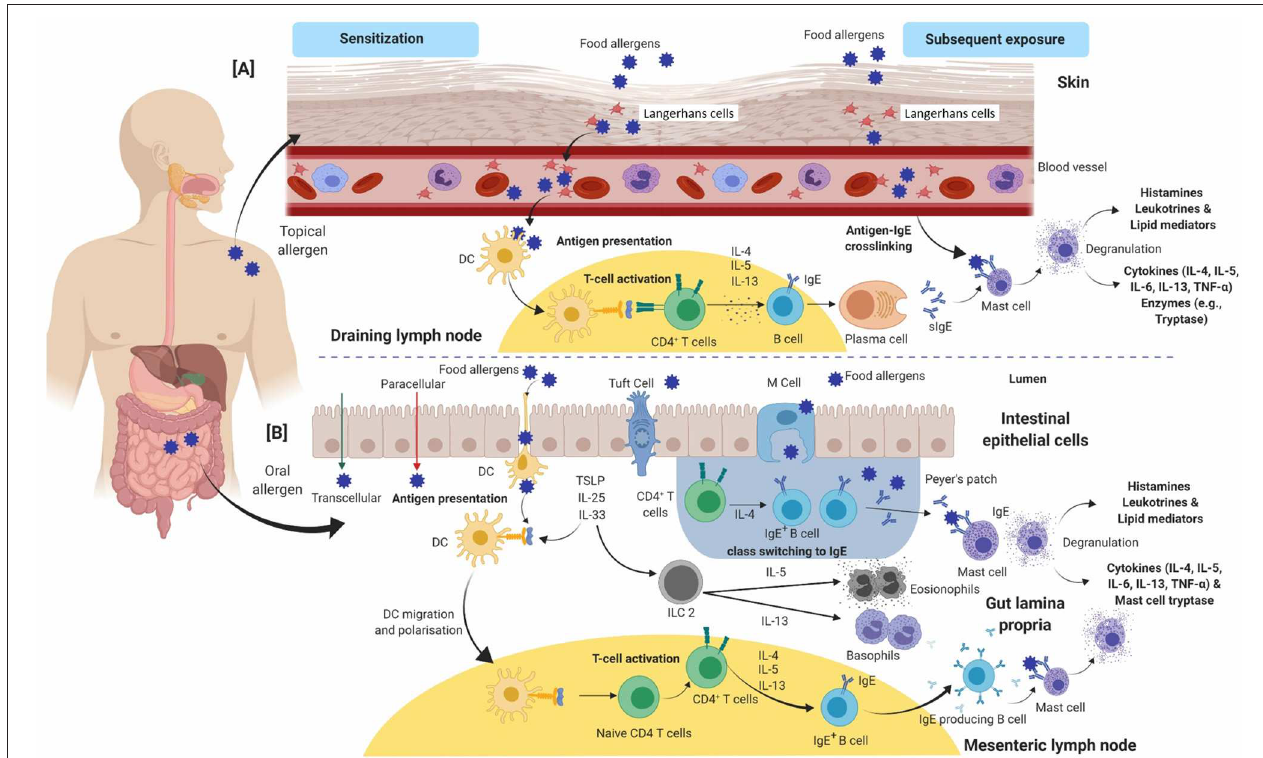
FIGURE 1 | An overview of the immunological events occurring during allergic sensitization and effector phase upon exposure to food allergens via (A) skin and (B) gut. (A) In the epidermis, allergens are sampled by Langerhans cells and the adaptive immune response is developed in draining lymph nodes. (B) In the gut lumen, allergens are taken up by DCs and the subsequent events take place in Peyer’s patches/mesenteric lymph nodes. Antigen-presenting cells (Langerhans cells in A or dendritic cells in B ) present allergen-derived peptides to naïve CD4 + T-cells via MHC-class II complex. In healthy individuals, a tolerogenic immune response develops, mediated by regulatory T-cells and IL-10. In susceptible individuals, naïve CD4 + T-cells polarize toward a Th-2 phenotype and produce IL-4, IL-5, and IL-13. IL-4 and IL-13 induce production of allergen specific IgE antibody by B cells and clonal expansion. Allergen-specific IgE binds to Fc ε RI receptors on the surface of basophils and mast cells. This entire process is called allergic sensitization. On subsequent exposure to the same allergen (via contact or ingestion), the allergens bind and crosslink cell-bound IgE antibodies, which triggers degranulation and release of chemical mediators such as histamine, cytokines and prostaglandins. These mediators are responsible for the manifestation of an allergic reaction. Cytokines including IL-4, IL-5, IL-6, IL-13, and TNF- α are further released which leads to cell-mediated late-phase allergic reactions through recruitment of eosinophils and Th-2-cells. CD, Cluster of differentiation; DC’s, Dendritic cells; Fc ε RI, High